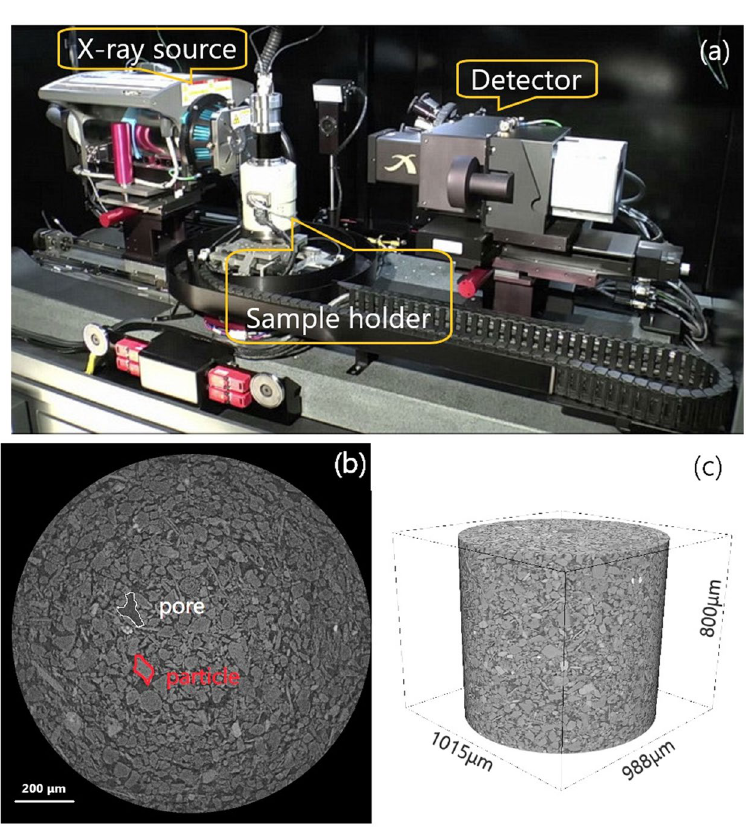
Figure 7. CT scan set-up: (a) the micro-CT scanner; (b) a grey scale image; (c) the cylindrical sample obtained from CT